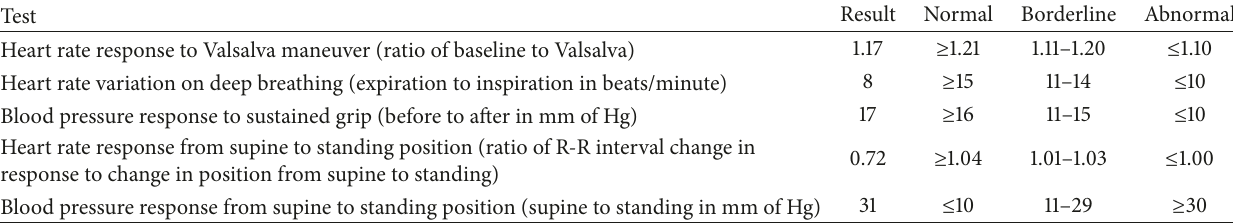
Table 1: Ewing’s battery of tests to assess cardiac autonomic